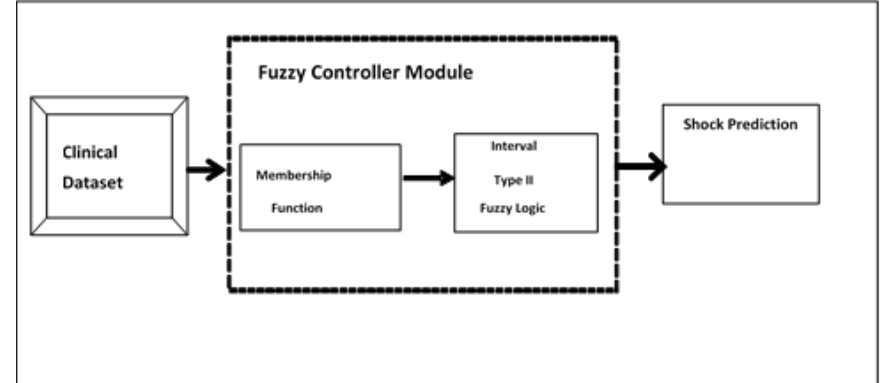
Fig. 4. Interval type-2 fuzzy logic framework for prediction problems in cardiac patient.